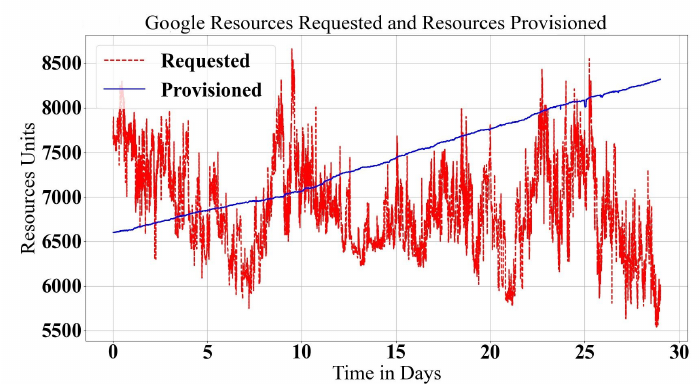
Figure 8. Data Center Provision Resources Shape.